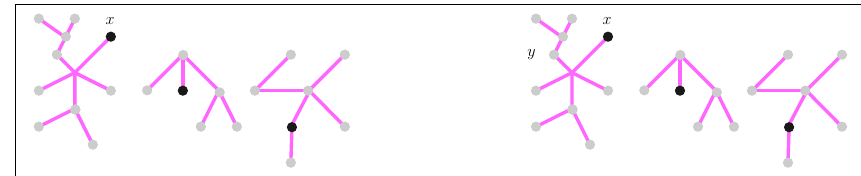
Figure 3: A 3 –rooted forest, x is a root (left) and a 3 –rooted forest x is a root and y is in the same component